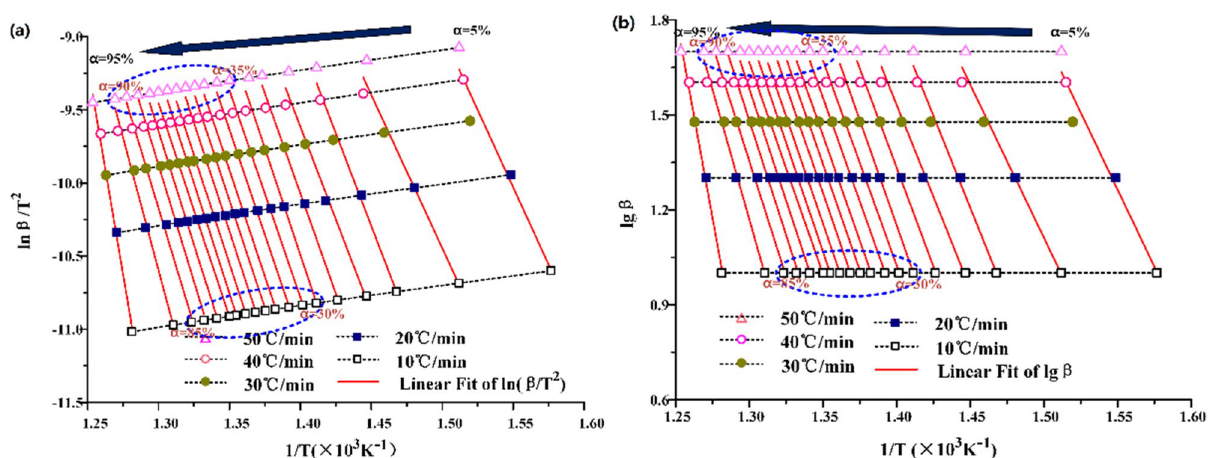
Figure 6. Calculating curve of activation energy under CO 2